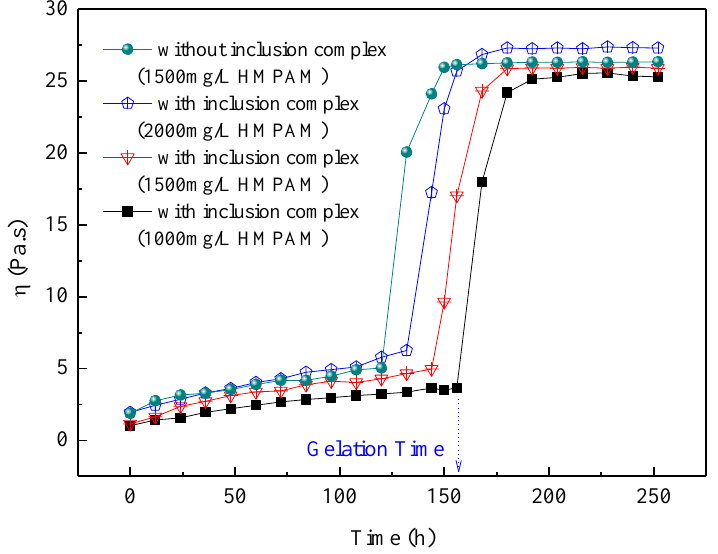
Figure 10. Influence of competitive agent on apparent viscosity of the gel system.